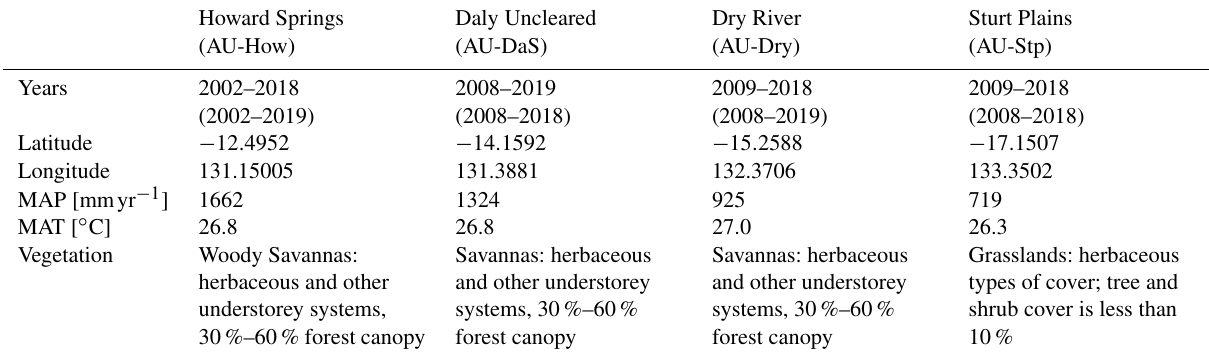
Table B1. Information for the four flux sites located in the Northern Australian Tropical Transect (NATT). This includes the mean annual precipitation (MAP), mean annual temperature (MAT), and the vegetation classification following the International Geosphere–Biosphere Programme (IGBP). The observed variables originate from eddy covariance data collected by the TERN-OzFlux facility. Further details of the site vegetation are available in Whitley et al. (2016).